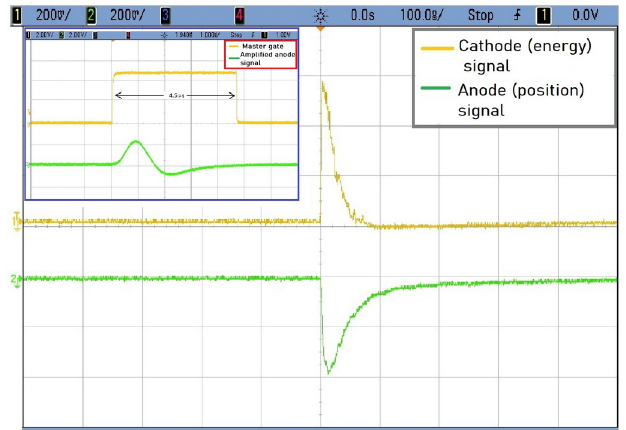
Fig. 3. Typical raw energy signal (from cathode) and position signal (anode). Inset: One of the anode (position) signals (bottom) as seen with respect to the reference master gate window (top).